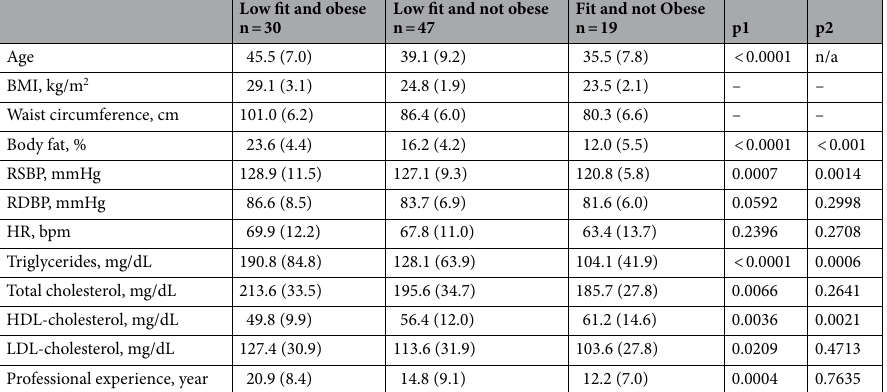
Table 3. Groups divided by METS and BMI (Mean and SD). p1: unadjusted; p2: adjusted for age. BMI body mass index, HR heart rate, RDBP diastolic resting blood pressure, RSBP systolic resting blood pressure.